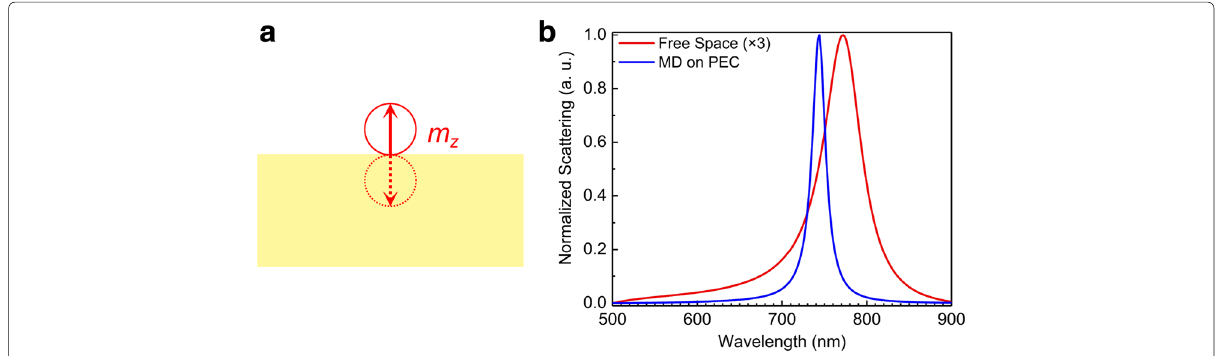
Fig. 3 a Schematically showing the z component of MD excited in the Si NS and the mirror image induced by the metal substrate and their phase relationship. b Normalized scattering spectra calculated for the Si NS with R = 100 nm suspended in air and placed on a PEC substrate by using the dyadic Green’s function